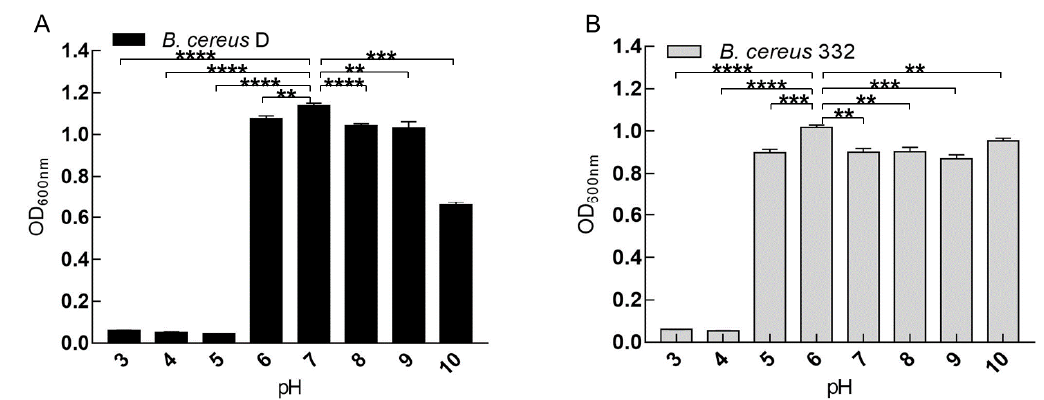
Figure 4. The effects of pH on the growth of B. cereus D ( A ) and B. cereus 332 ( B ). **** indicates p < 0.0001, *** indicates p < 0.001, ** indicates p < 0.01, and * indicates p < 0.05.